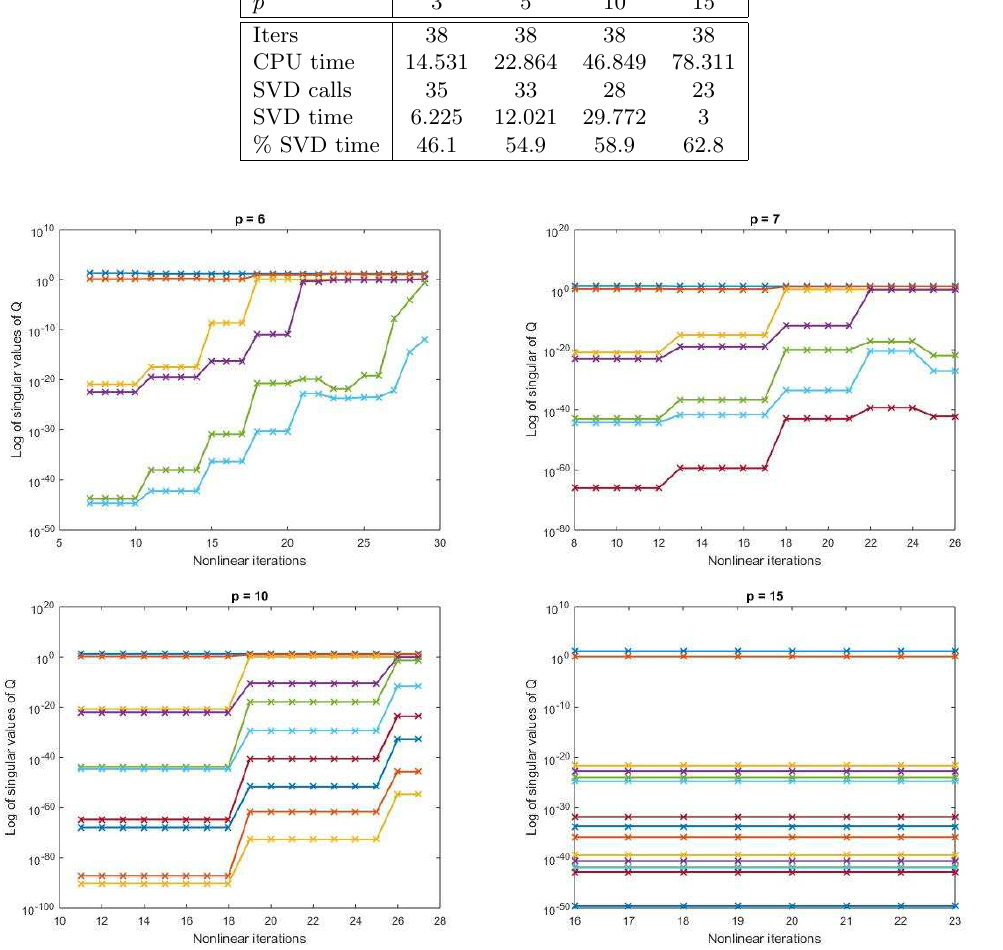
Table 4. Performance of the BRR method for Problem 2.